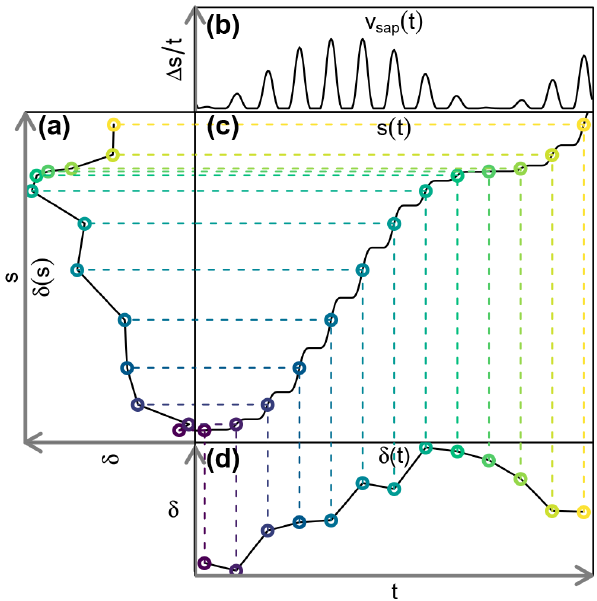
Figure 1. Exemplary transformation of (d) a tracer concentration time series δ(t) to (a) a concentration function depending on the cumulative sap flow distance δ(s) . A time series of (b) sap flow velocities v sap (t) is needed for the construction of (c) the auxiliary function s(t)